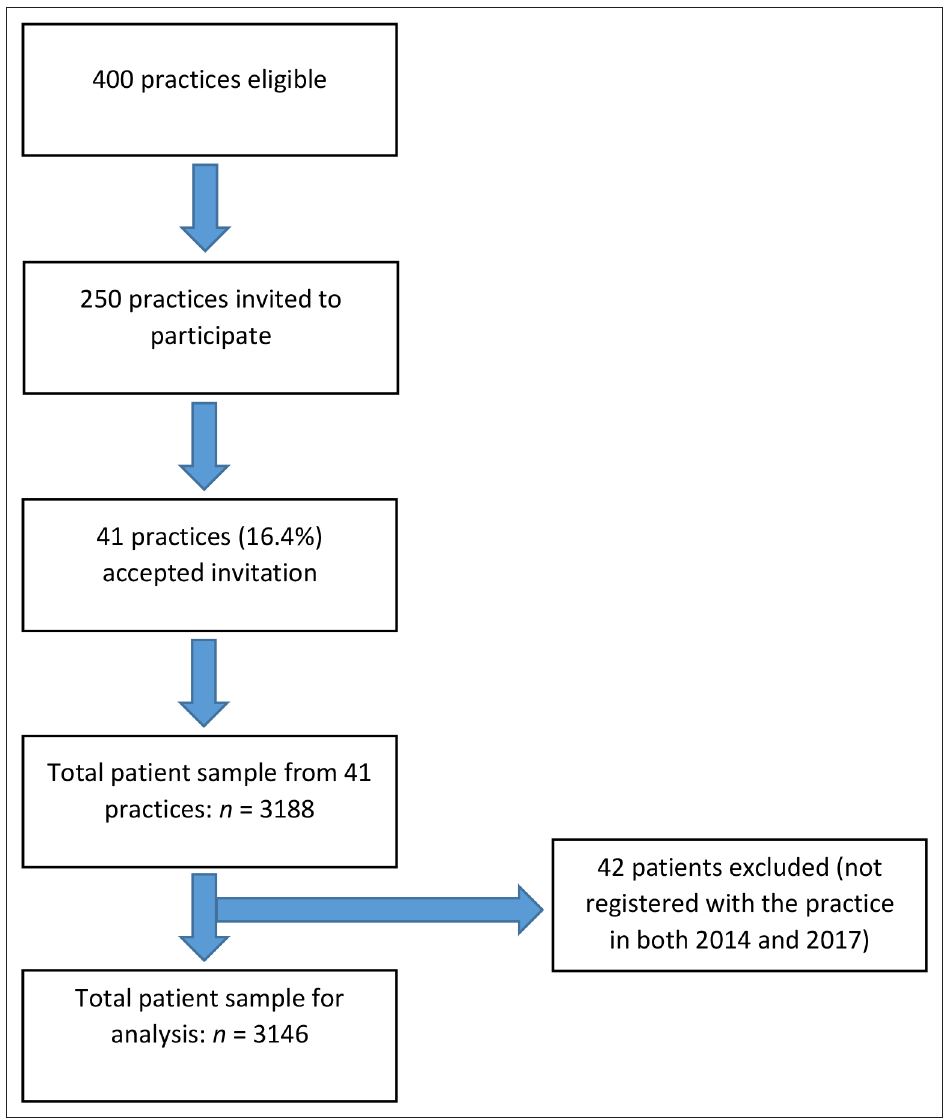
Figure 1 PRISMA diagram of participant